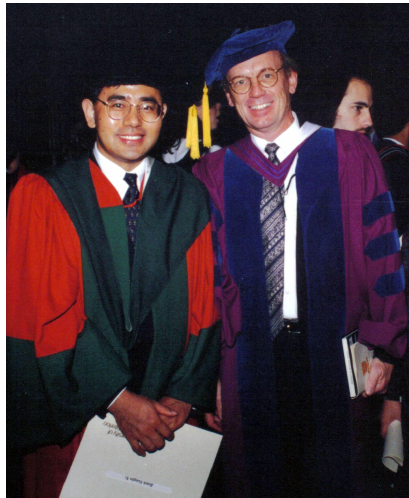
Figure 2: David Li and Harry Panjer at David Li’s PhD graduation ceremony in